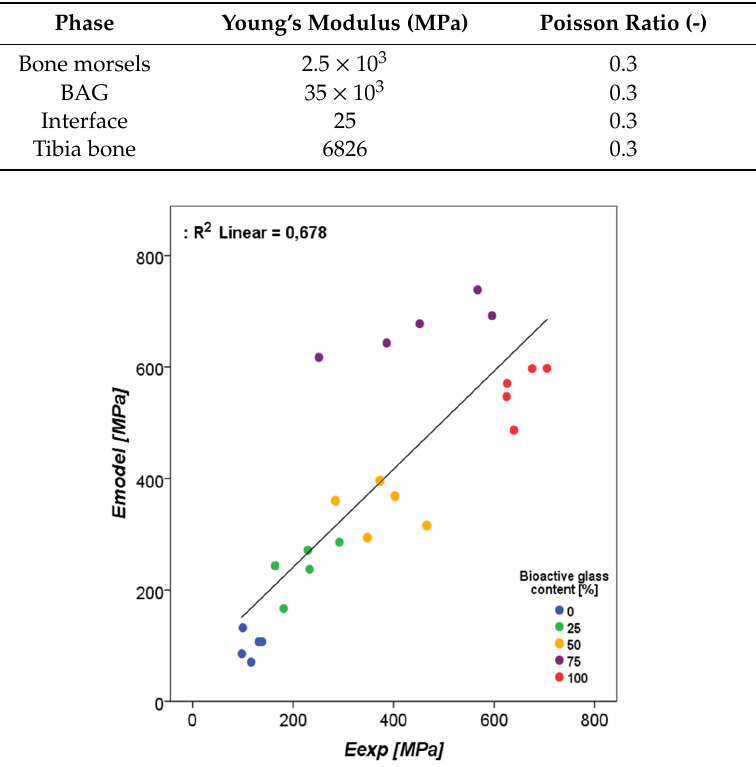
Figure 8. The regression of the experimental compression moduli as measured by Hulsen et al. (2016) [11] vs. the estimated compression moduli for the materials with increasing bioactive glass contents. Table 5. Prescribed material properties for each phase in the human tibia high-friction compression (FE) model.